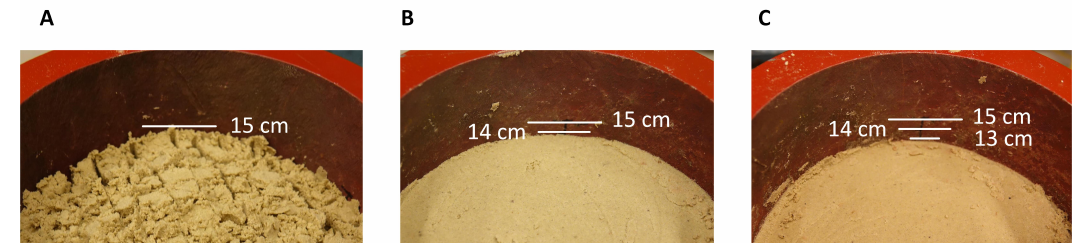
Figure 3. ( A ) Low traffic condition with the density of 1.35 g/cm 3 . ( B ) Medium traffic condition with the density of 1.45 g/cm 3 . ( C ) High traffic condition with the density of 1.55 g/cm 3